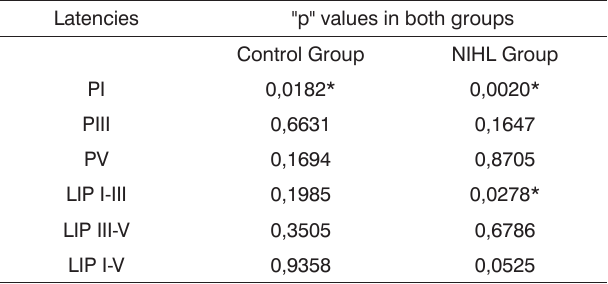
Table 3. Descriptive levels of the Wilcoxon test (“p” values) obtained through the comparison of the absolute latencies and the LIPs ac- cording to laterality, in both groups.